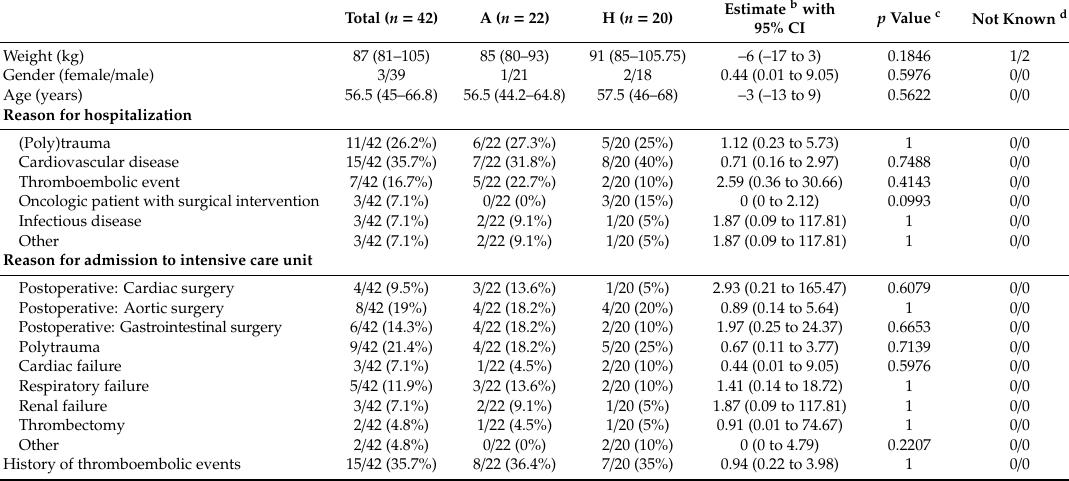
Table 1. Characteristics a of patients.